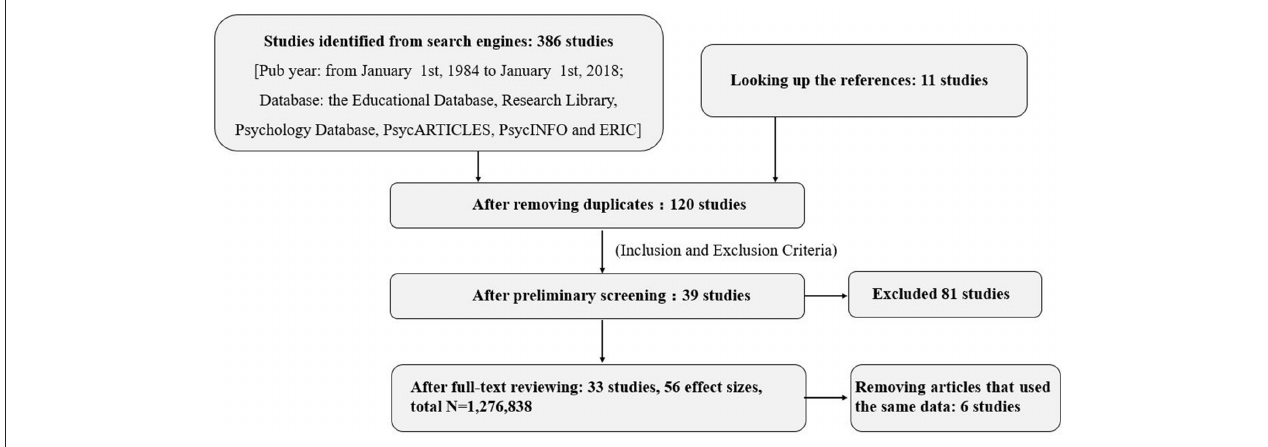
FIGURE 1 | Flow diagram showing the process through the literature search, study selection, and study inclusion for the meta-analysis.